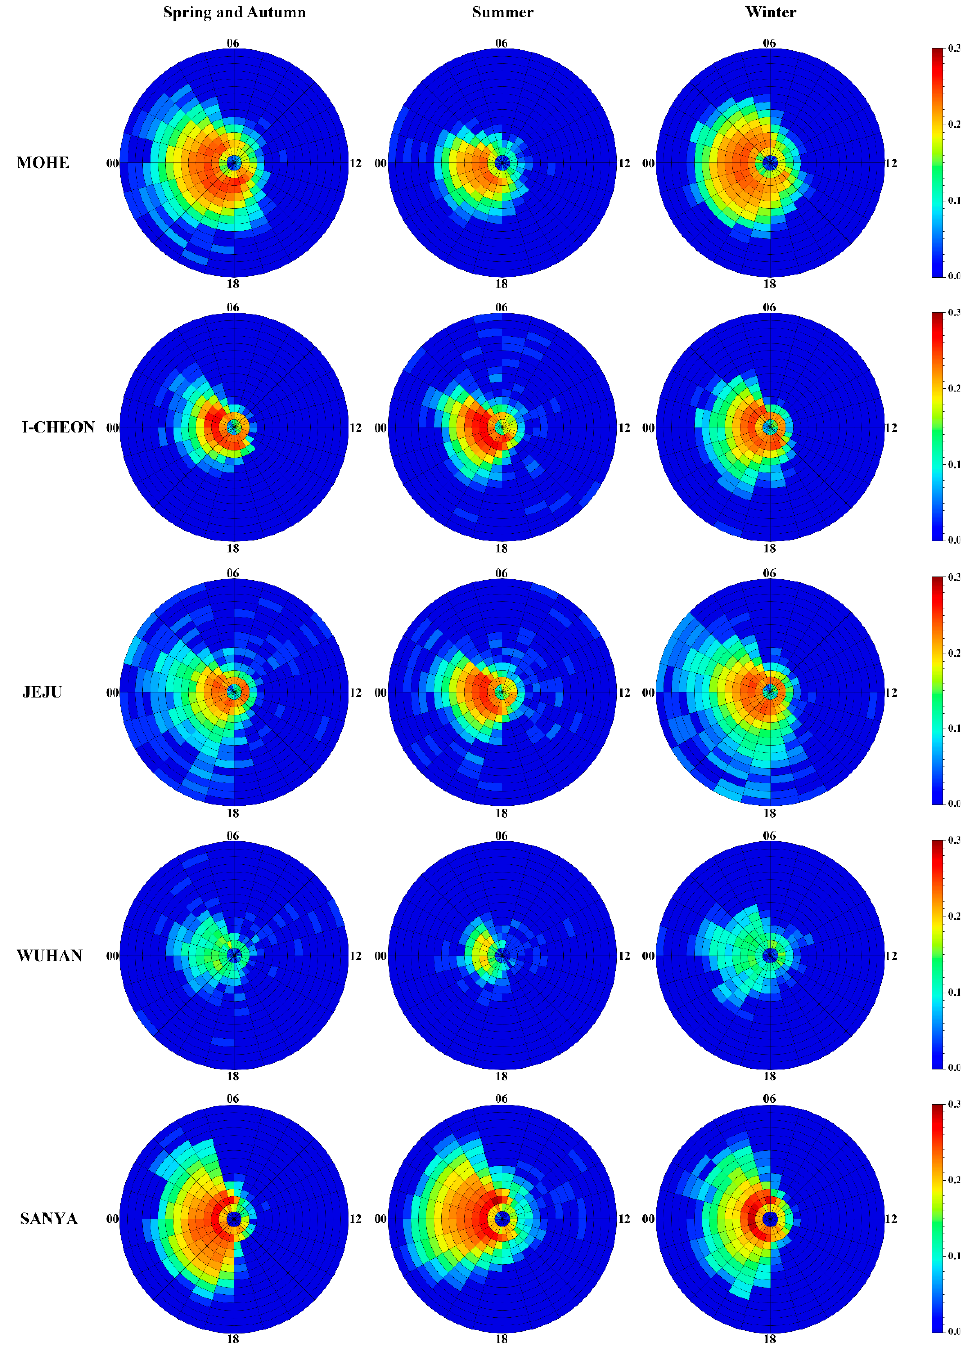
Figure 5. Frequency spread-F (FSF) index distribution in summer, winter, and equinox (spring and autumn) in Mohe, I-Cheon, Jeju, Wuhan, and Sanya, which is binned into the function of local time 0:00–24:00 LT and heights 200–500 km within a grid of 1 h × 20